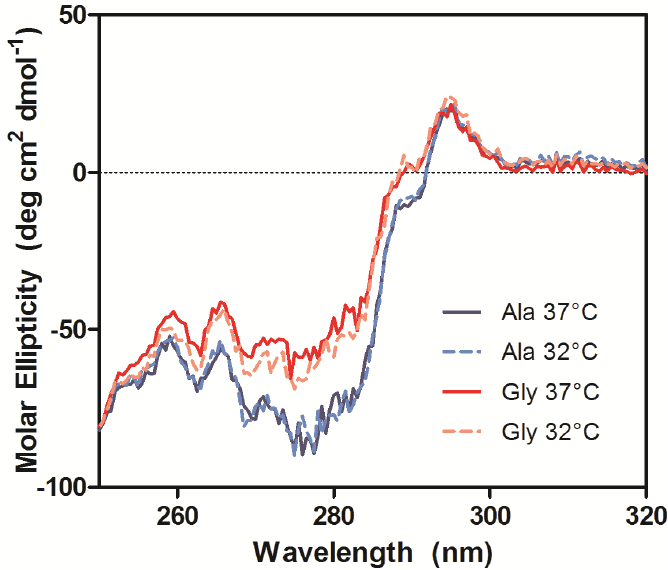
Figure 8. Near-UV CD spectra of purified Ala-138 and Gly-26 mAb cultured at 37 °C (solid lines) and 32 °C (dashed lines). Each trace is the average of three acquisitions and has had the phosphate buffer (20 mM, pH 8) signal